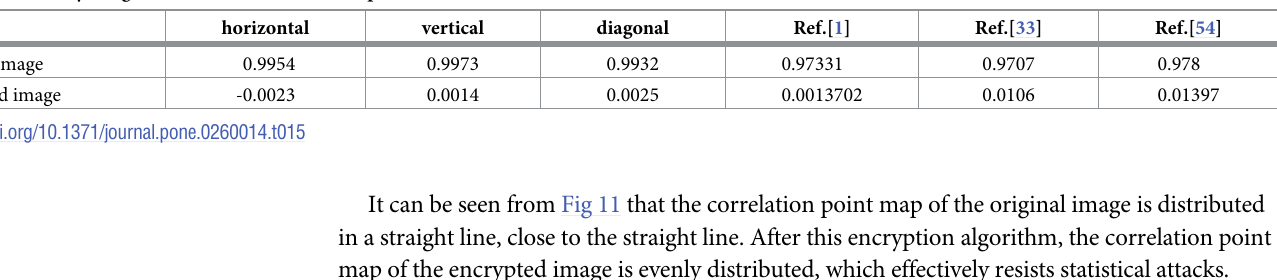
PLOS ONE | https://doi.org/10.1371/journal.pone.0260014 November29,